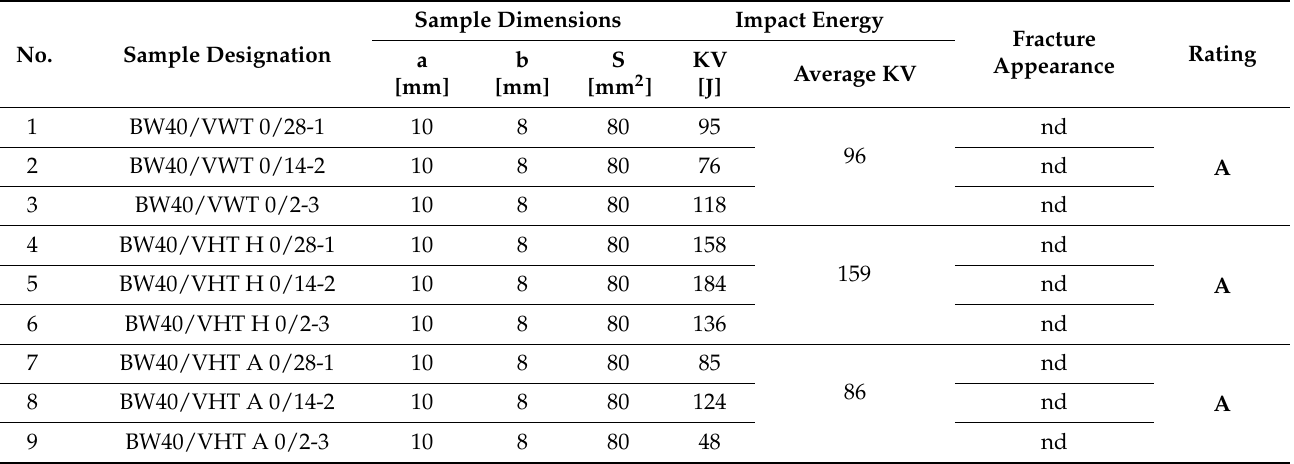
Table 4. Results of impact tests for HTK900H + A6 casting welded